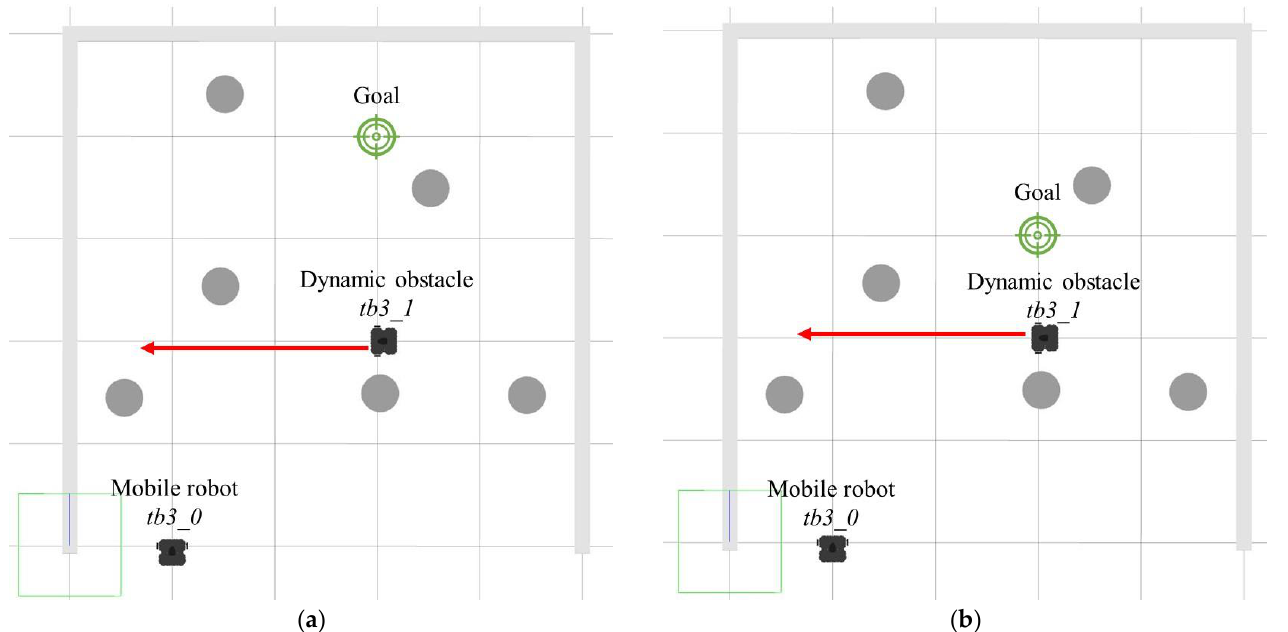
Figure 14. ( a ) Gazebo simulation for dynamic environment scenario 2 with goal point of (3.0,4.0) for 𝑡𝑏3_0 , ( b ) Gazebo simulation for dynamic environment scenario 2 with goal point of (3.0, 3.0) for 𝑡𝑏3_0 .